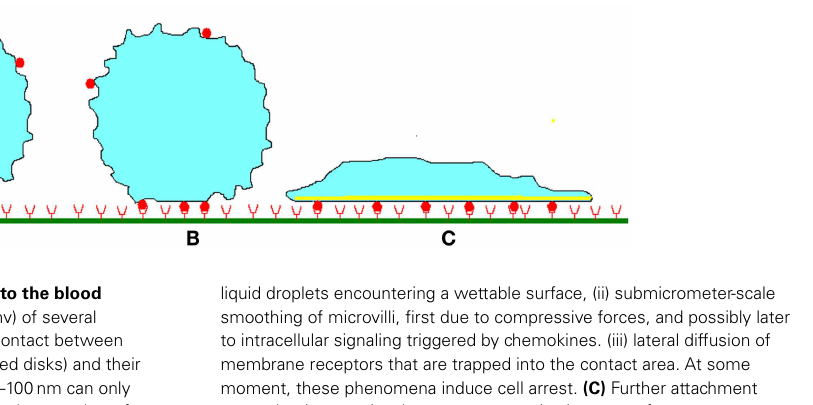
FIGURE 3 | Stabilization of leukocyte attachment to the blood vessels . (A) When a cell studded with protrusions (mv) of several hundreds of nm length encounters a plane surface, contact between membrane receptors such as selectins or integrins (red disks) and their ligands (red half circles) of total length lower than 50–100nm can only occur on the tip of protrusions, allowing formation of a low number of bonds. As indicated in text, very high association rates are needed to tether freely flowing leukocytes within a molecular contact shorter than a few milliseconds and initiate rolling. (B) Within the following tens of seconds, rolling cells undergo (i) micrometer-scale flattening similarly to